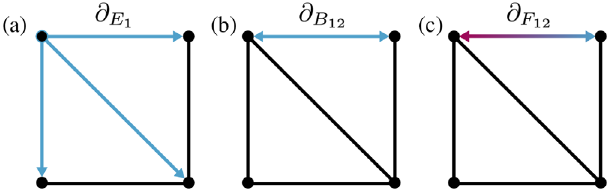
FIG. 2. Parameterizing perturbations. Any perturbation of rates can be decomposed into the variation of some combination of (a) vertex parameters, (b) edge parameters, and (c) asymmetric edge parameters. Affected rates are